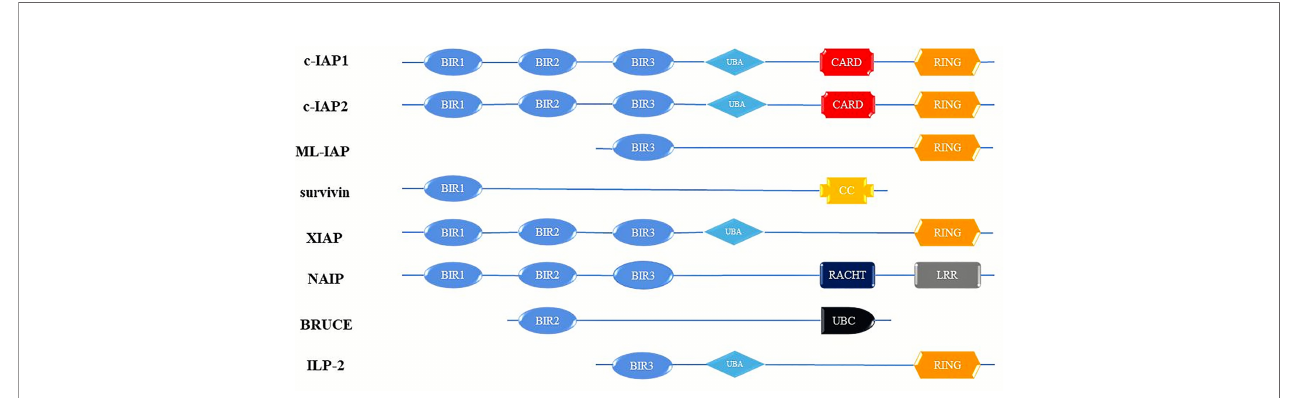
FIGURE 1 | Schematic diagram of domain structure of human IAP proteins. BIR, baculovirus IAP repeats; CARD, caspase activating and recruitment domain; RING, ring zinc- fi nger. c-IAP1, cellular Inhibitor of apoptosis protein; c-IAP2, cellular Inhibitor of apoptosis protein; ML-IAP, livin/melanoma-Inhibitor of apoptosis protein; XIAP, Survivin, X-linked Inhibitor of apoptosis protein; NAIP, Neuronal apoptosis inhibitory protein; BRUCE, Baculoviral IAP repeat-containing ubiquitin-conjugating enzym; ILP-2, Inhibitor of apoptosis protein-like